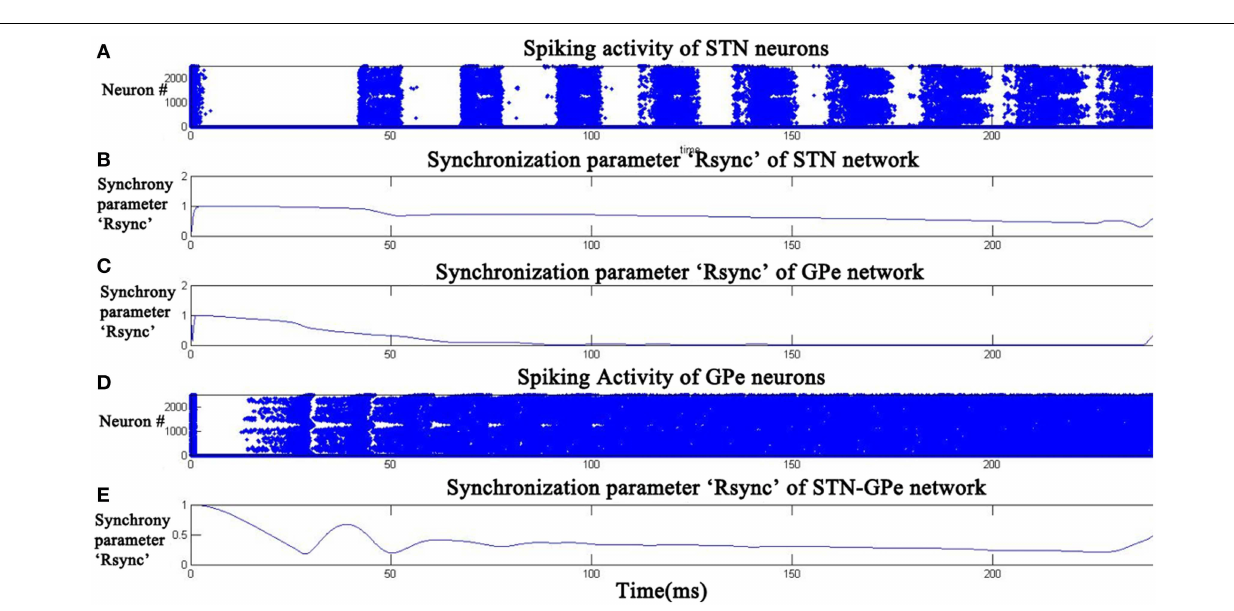
in general excitatory neurons (Hansel et al., 1995) and such synchrony was found to be absent at high DA levels. GPe neurons show a synchronized firing pattern with decreased lateral synaptic weights at low DA level ( Figure 9B ) (Wang and Rinzel, 1993). On the contrary, a high lateral inhibition at high DA prevents the neighborhood neurons from firing at the same time, thereby producing a desynchronized firing